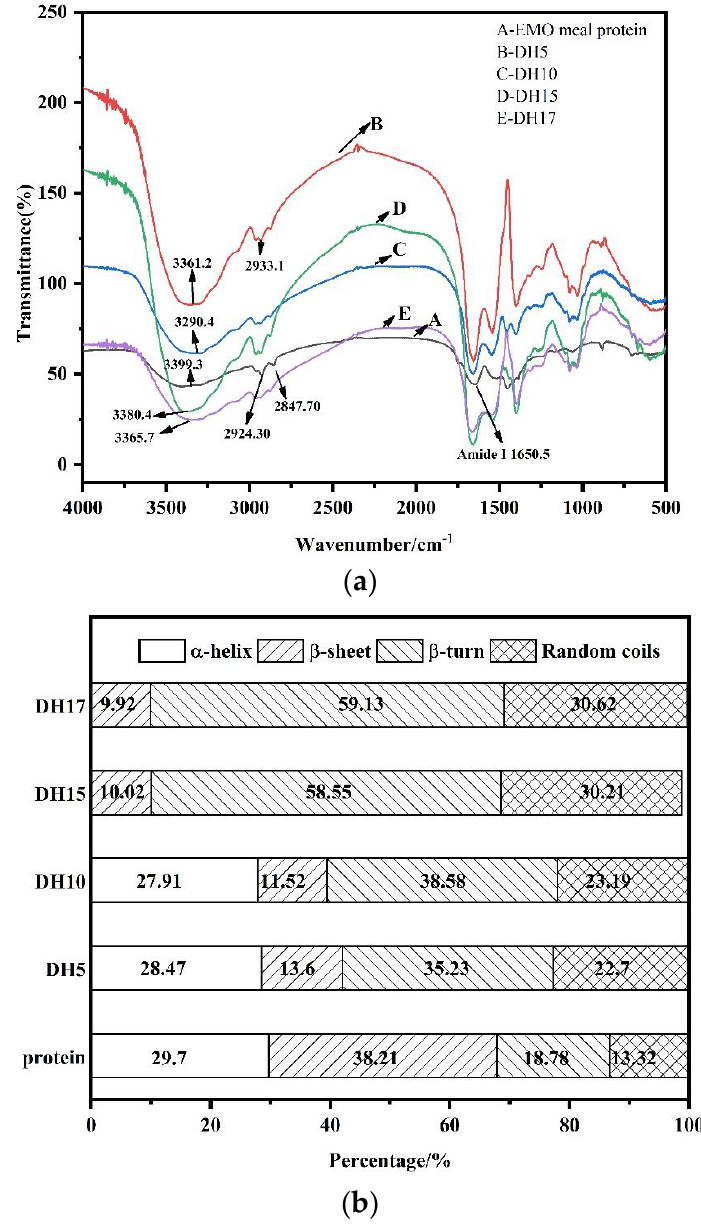
Figure 5. Fourier transform infrared spectra ( a ) and the percentages of structural units ( b ) of EMO meal protein and hydrolysates with different DH.